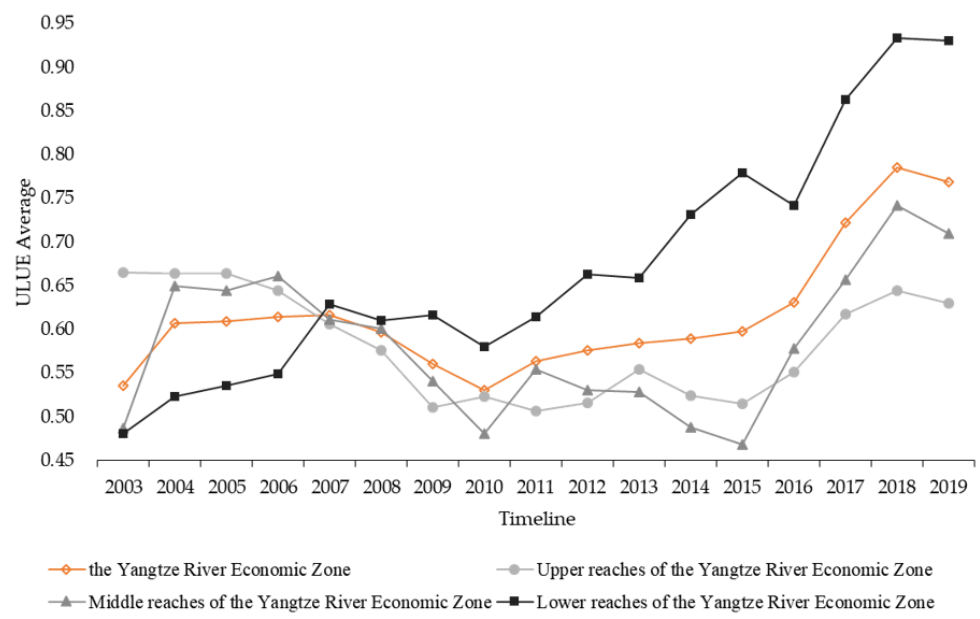
Figure 3. Temporal series variation of ULUE in Yangtze River Economic Zone.